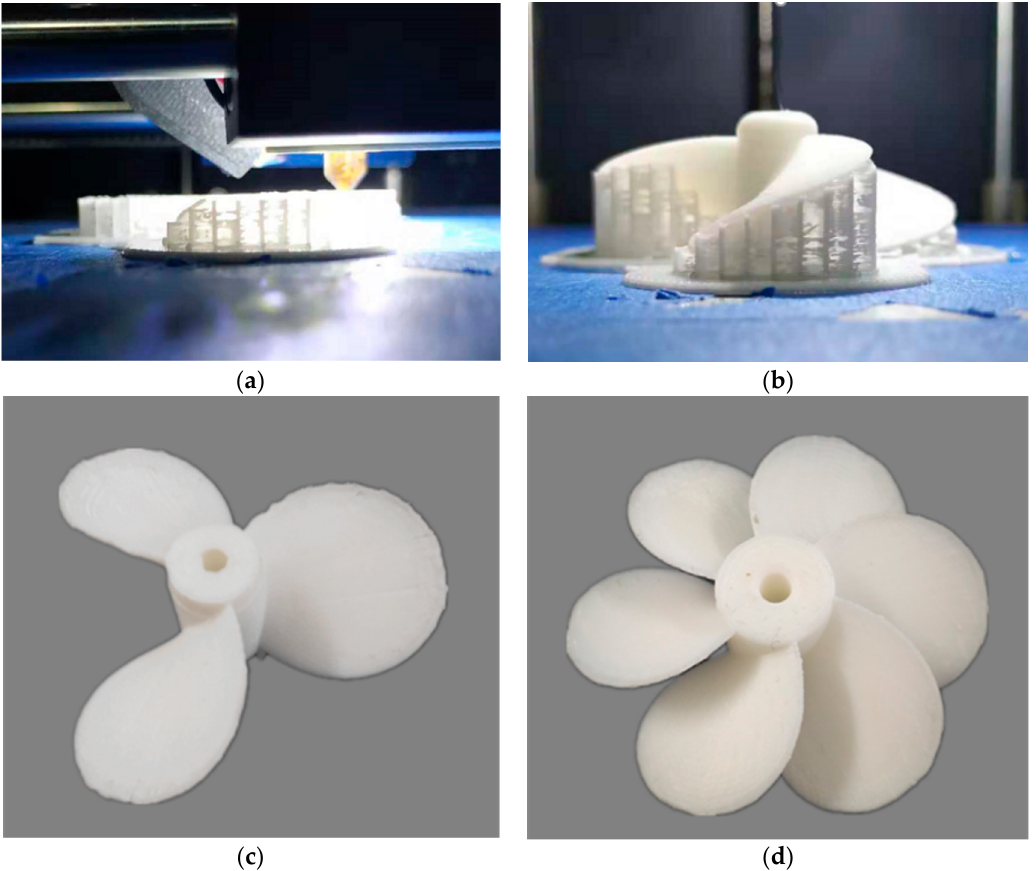
Figure 4. 3D printing for propeller model. ( a ) Printing status; ( b ) print completed; ( c ) propeller ‐ A; ( d ) propeller ‐ B.